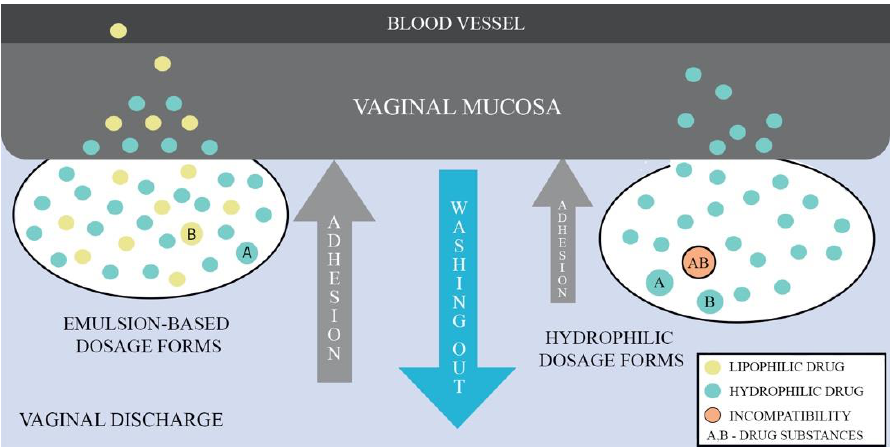
Figure 2. Comparison of vaginal emulsion-based and hydrophilic drug dosage forms.